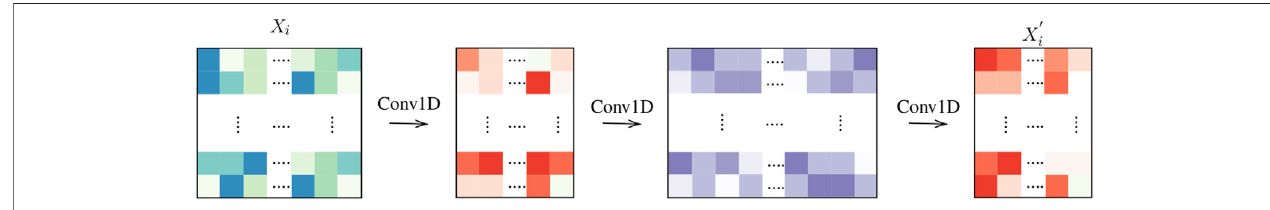
FIGURE 4 | Tile computation: Three layers.